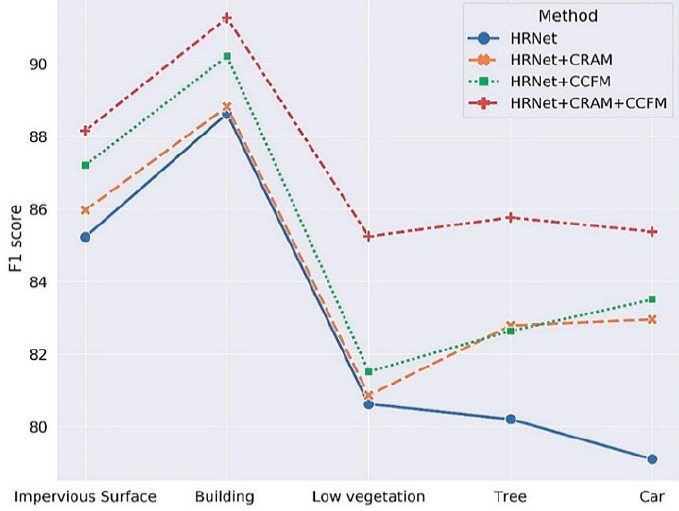
Figure 12. Visualization of ablation study results of CRAM and